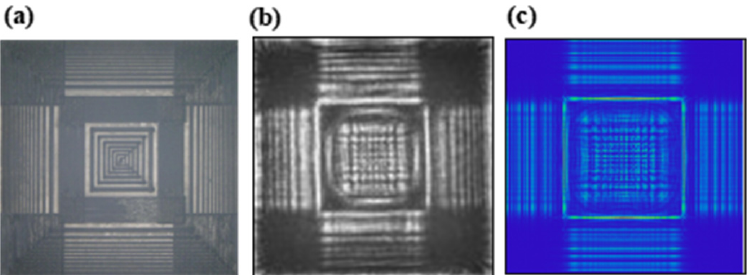
Figure 12. ( a ) PB-FZP fabricated by femtosecond laser; ( b ) Experimental focal plane; ( c ) Simulated Focal plane. The given results proposed different values of phase shift parameter α in X and Y